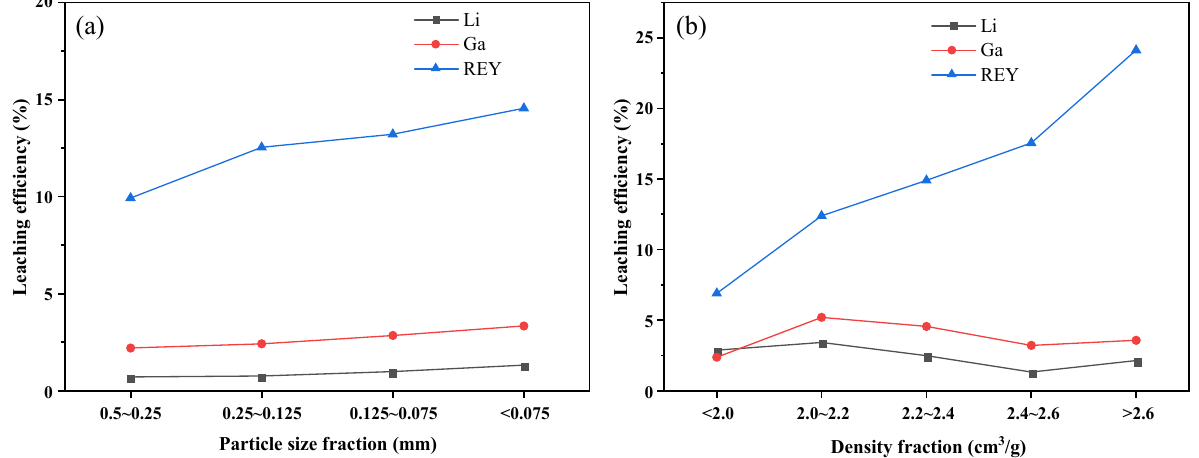
Figure 6. Leaching characteristics of Li, Ga, and REY in different ( a ) particle size fractions, and ( b ) density fractions.